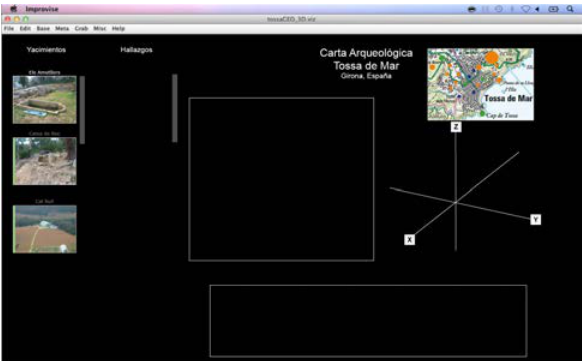
Figure 2. The 3D Collaborative